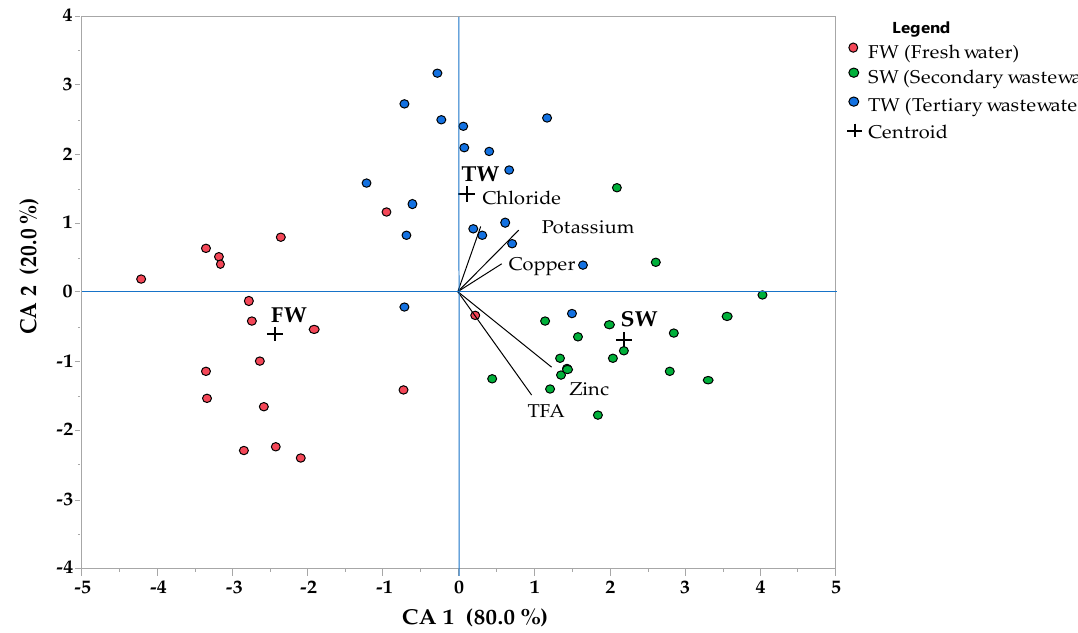
Figure 2. Stepwise discriminant analysis biplot of the quality parameters of artichoke heads considering the irrigation factor as the discriminant variables. For each data point, the irrigation treatment code is included. TFA: 4-hydro-3-methylcinnamale (Trans-ferulic acid).